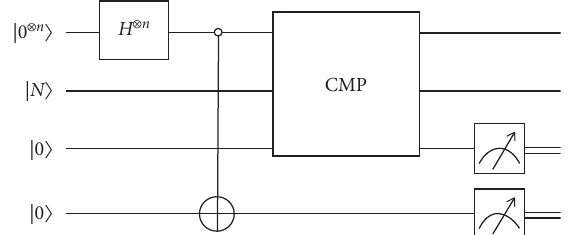
Figure 1: Quantum circuit of getting ( 1/ Hadamard operation and ○ represents the control qubit condi- tional being set to zero.